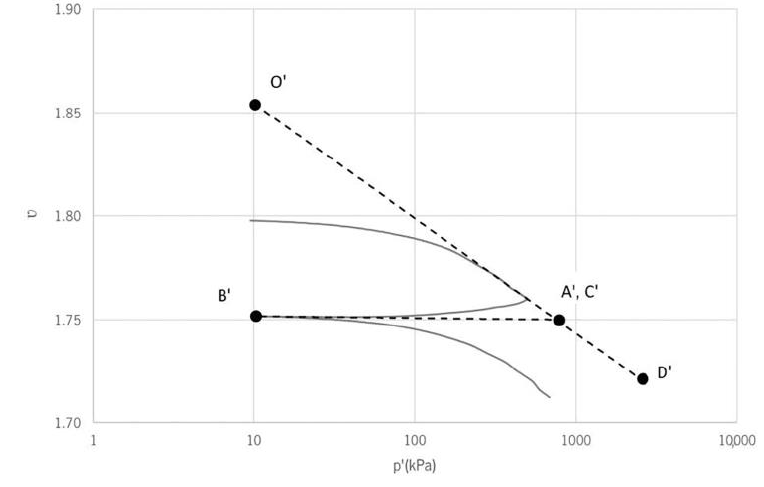
Figure 17. Isotropic compression and expansion curve (stabilized specimen).